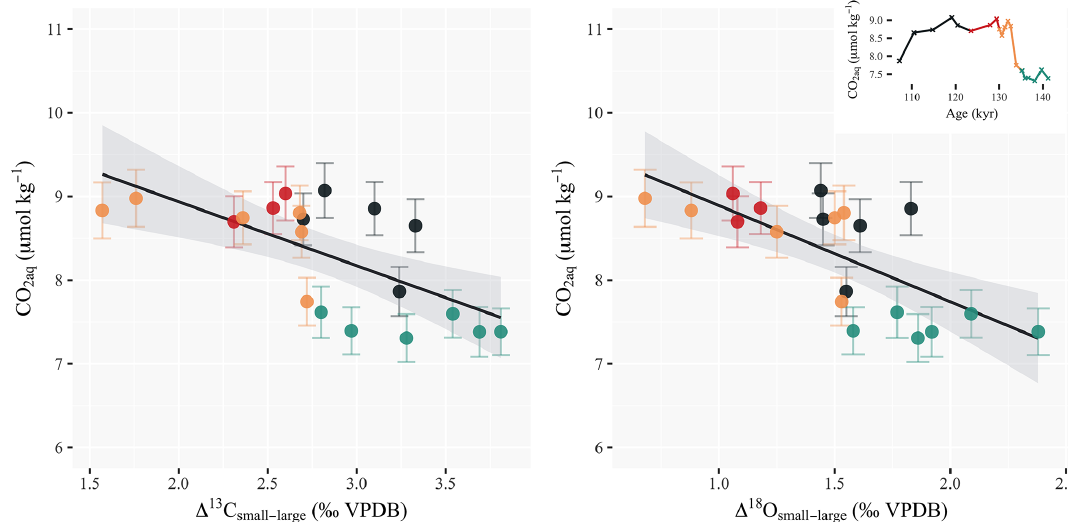
Figure 4. Scatterplots of the differential vital effects in carbon and oxygen vs. aqueous CO 2 concentration. (cid:49) 13 C small − large and (cid:49) 18 O small − large correlate with changes in the ambient CO 2 concentrations ( R 2 = 0 . 44, p < 10 − 2 and R 2 = 0 . 51, p < 10 − 3 , respectively). Data points are colored according to the time period considered: the glacial maximum (green), Heinrich Event 11 (orange), the interglacial (red) and glacial inception (black). Inset are the surface ocean CO 2 concentrations across the deglaciation (calculations are detailed in the “Material and methods”